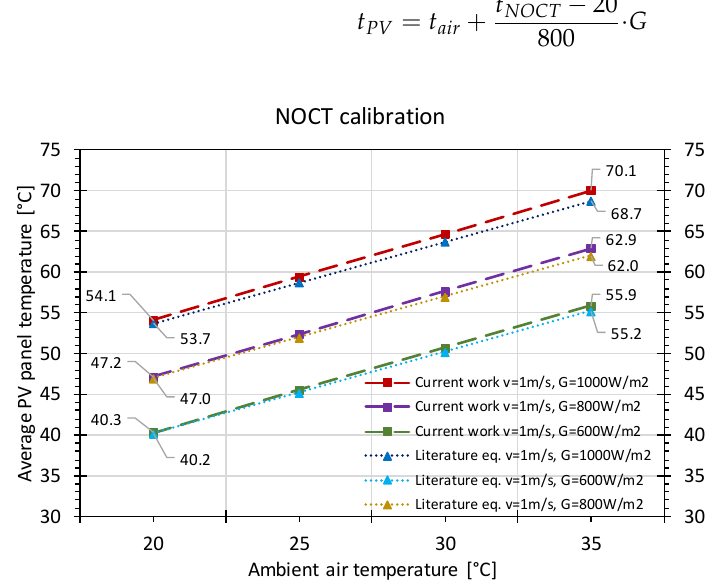
Figure 6. Calibration of the model according to NOCT conditions variation.